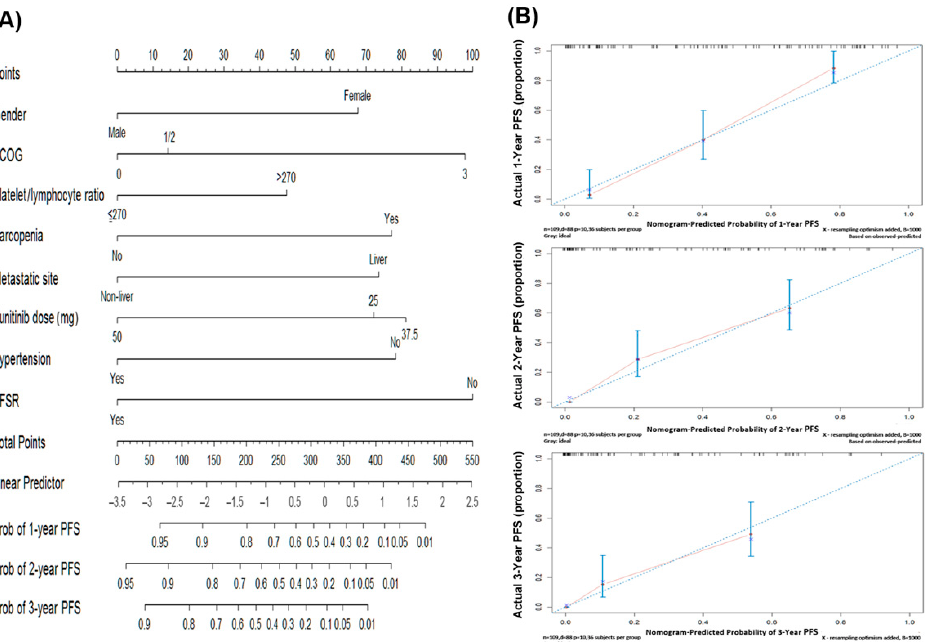
Figure 2. Nomogram and calibration plots: ( A ) Nomogram based on 109 patients with advanced GISTs treated with sunitinib. ( B ) Calibration curves with nomogram predicted 1-year, 2-year, and 3-year PFS and actually observed survival.